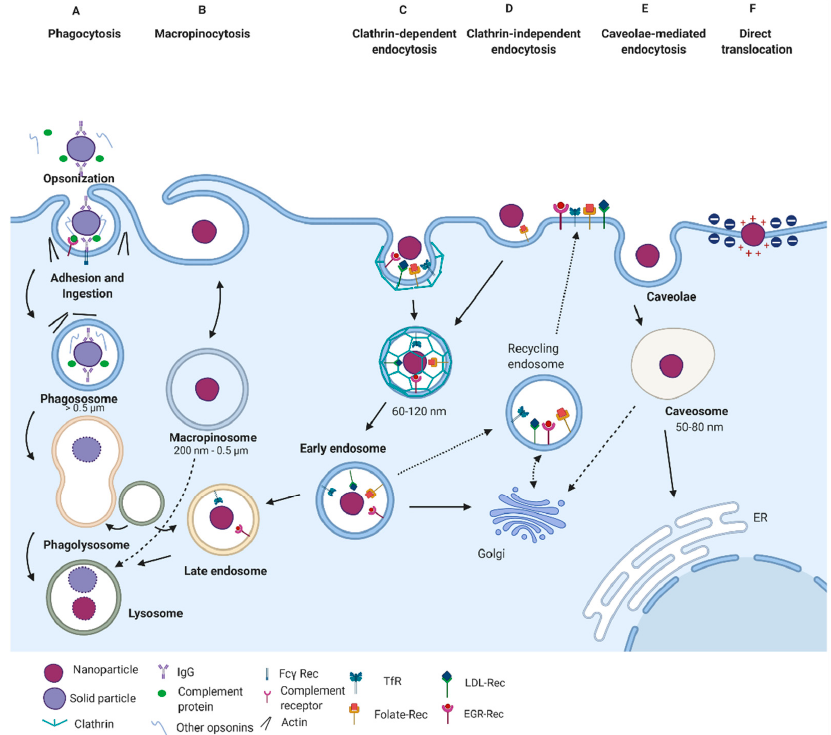
Figure 2. Mechanisms of internalization in living cells. ( A ) Phagocytosis; ( B ) Macropinocytosis; ( C ) Clathrin-dependent endocytosis; ( D ) Clathrin-independent endocytosis; ( E ) Caveolae-mediated endocytosis; ( F ) Direct translocation. Other conventions: IgG, Immunoglobulin G; Fc γ Rec, Fc γ receptor; TfR, Transferrin receptor; Folate-Rec, Folate receptor; LDL-Rec, low-density lipoprotein receptor; EGF-Rec, Epidermal growth factor receptor; ER, Endoplasmatic reticulum. This figure